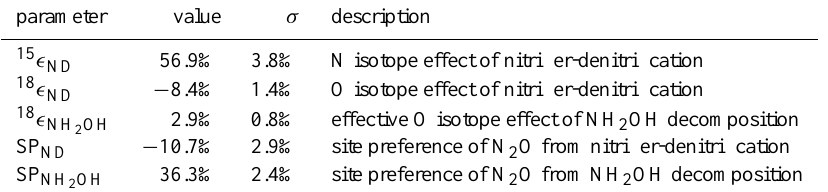
Table 3. Isotope effects and signatures derived in this paper for N 2 O production by N. marina C-113a. Best fit values of model parameters for Eq. (6) are given with standard deviations based on covariance estimates in Bard